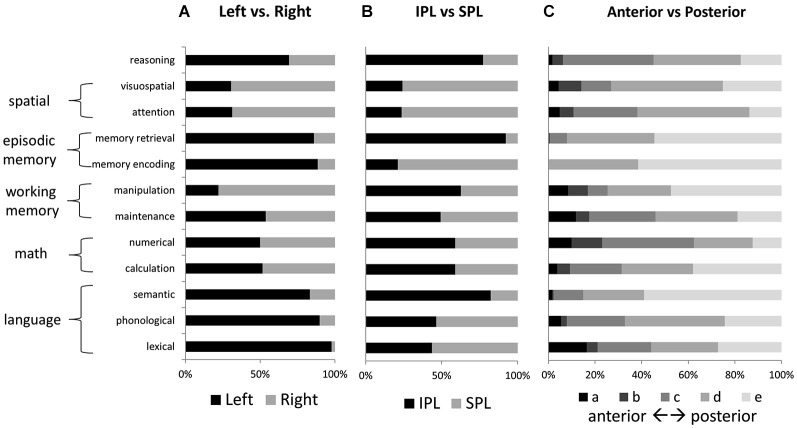
Relative activation volumes associated with each term, for (A) left vs. right parietal cortex, and (B) IPL vs. SPL; and (C) anterior to posterior parietal cortex. All bars add up to 100%. Terms are grouped according to the higher-level category to which they are thought to correspond.